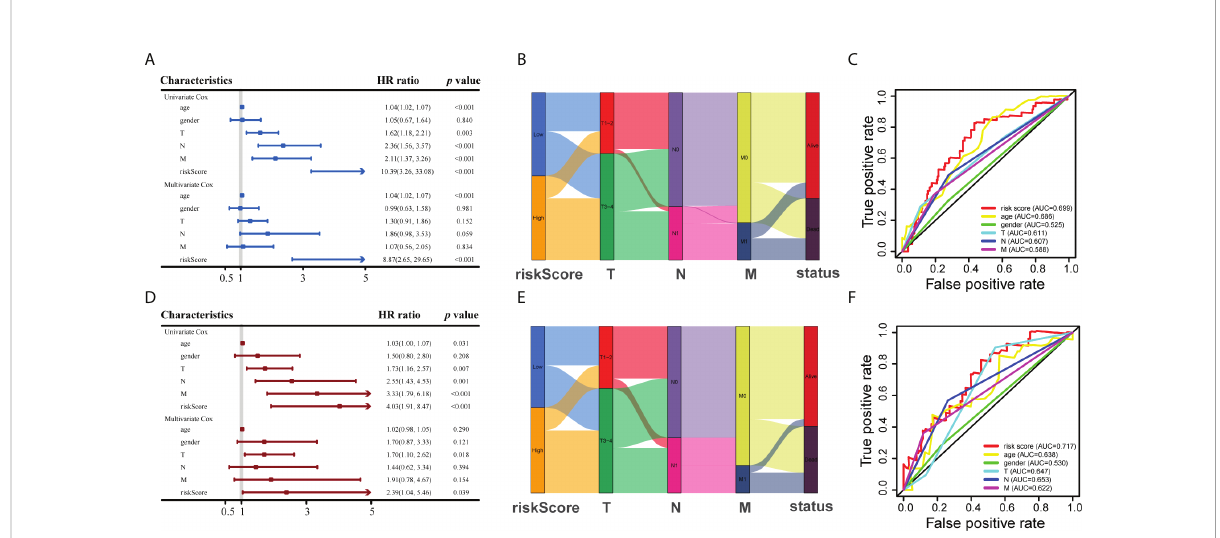
FIGURE 5 Analyses of prognostic values using the risk score and clinical variables. (A, D) Risk score was revealed to be strongly associated to OS in the univariate Cox analysis and multivariate Cox analysis in training and testing cohort, respectively. (B, E) Alluvial diagrams showing the associations between risk scores and clinical variables in training and testing groups, respectively. (C, F) ROC curve analyses of the risk scores and clinical variables in training and testing sets, respectively.